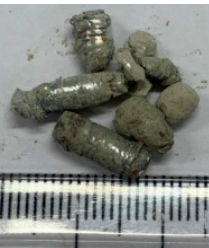
Figure 5. Photographs of the back-extruded aluminum during processing when the offset between the hole and the processing material is low during processing using 4- and 6-mm hole sizes.